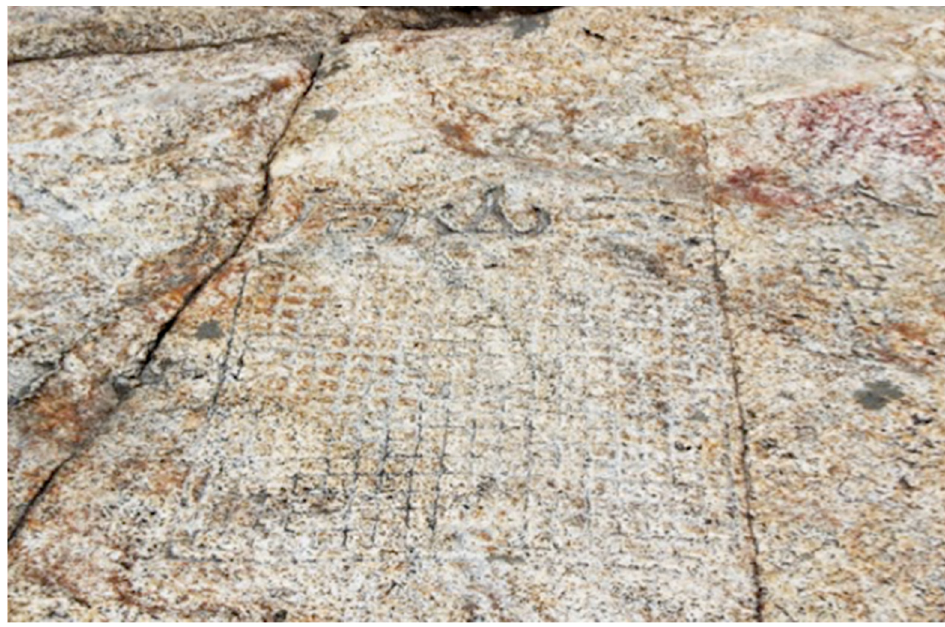
Figure 11. Rock carving of a chessboard titled Samsan’guk , Chosŏn period. Ten Thousand Falls Ravine, Inner K ŭ mgang, Mt. K ŭ mgang, DPRK. Photograph by author.